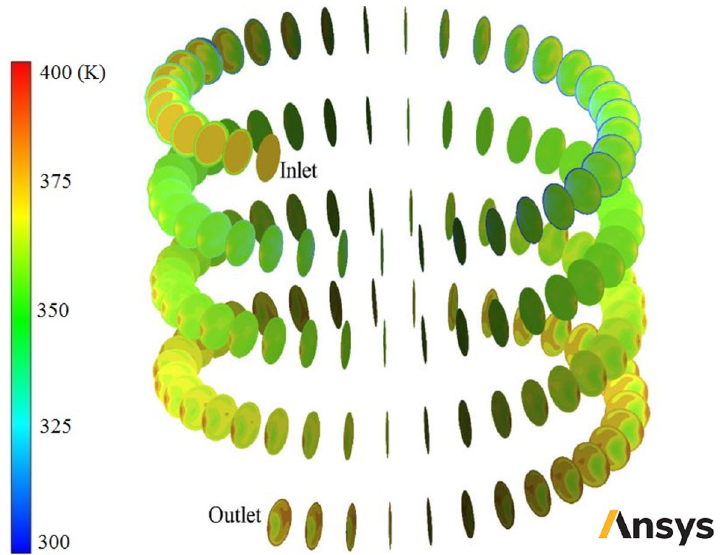
Figure 8. Temperature contours in some cross-sections of smooth-wall helical heat exchanger filled with two- phase NNNF ( φ = 1% and d np = 20 nm) (Images used courtesy of ANSYS,